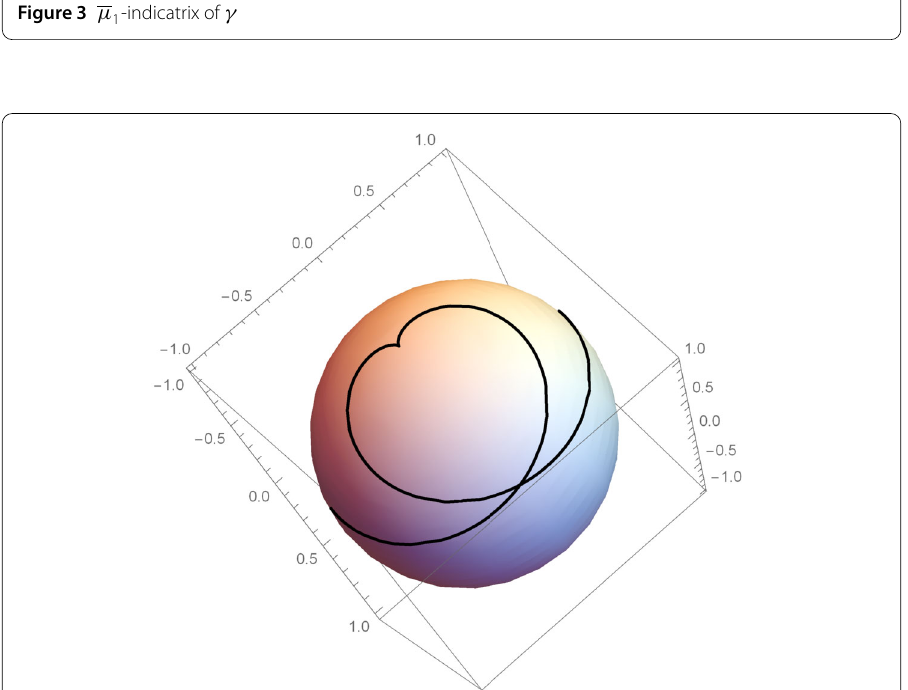
Figure 4 μ 2 -indicatrix of γ